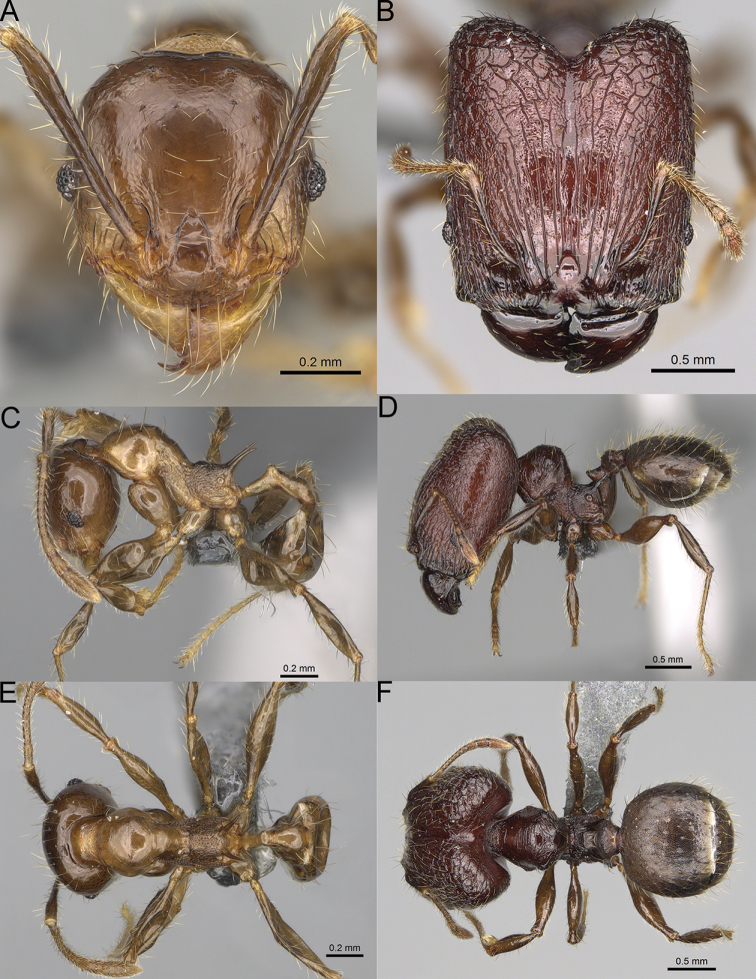
Pheidole
ocypodea sp. nov., full-face view (A), profile (C), and dorsal view (E) of paratype minor worker (CASENT0923220) and full-face view (B), profile (D), and dorsal view (F) of holotype major worker (CASENT0304390).